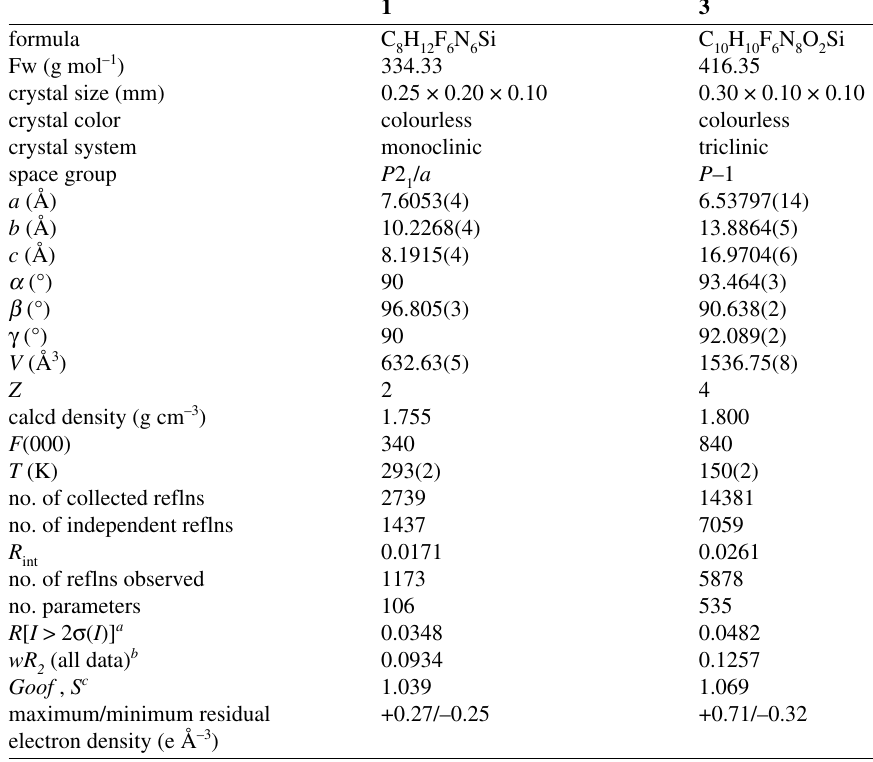
Table 1. Experimental data for the X-ray diffraction studies on compounds 1 and 3